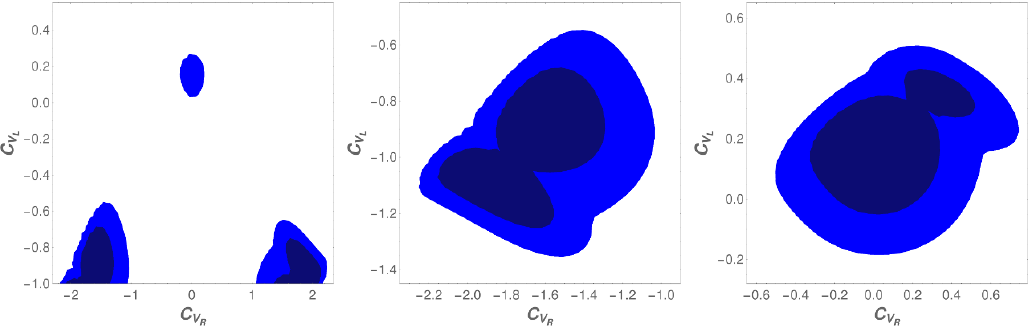
D (cid:3) , restricting L > 1, relative to the L (cid:0) > 1, see text. L (cid:0)